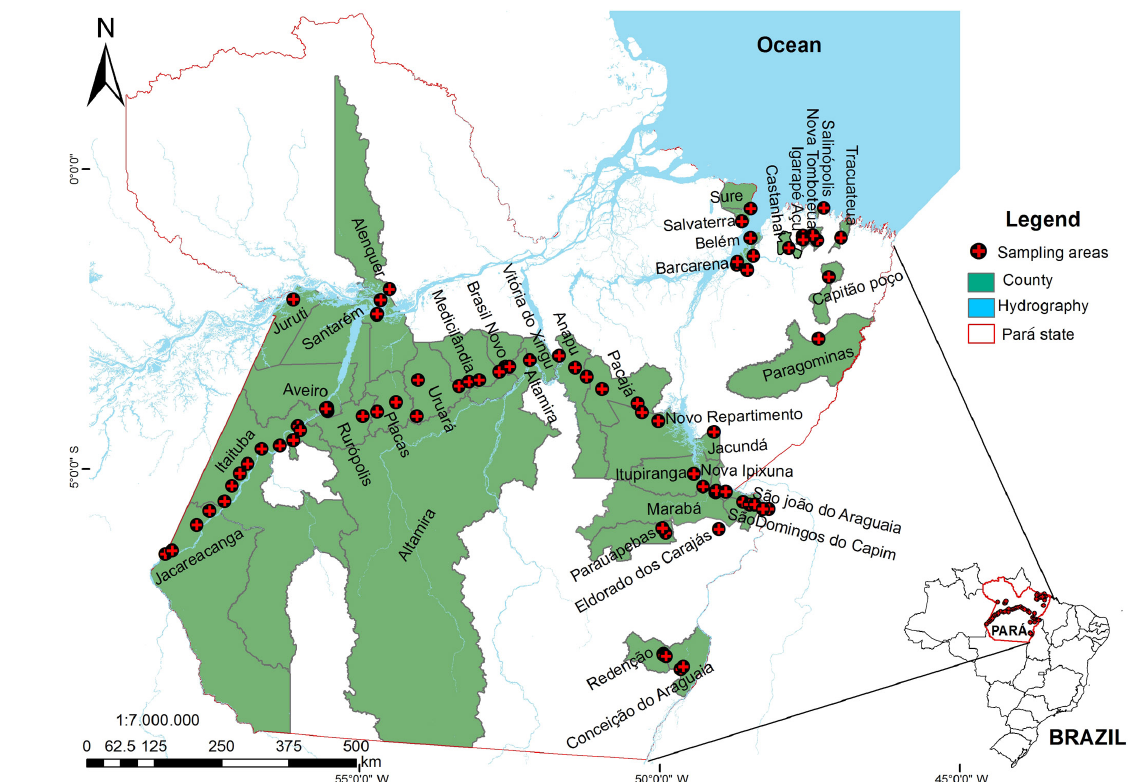
Figure 1. Map of soil sampling areas of the state of